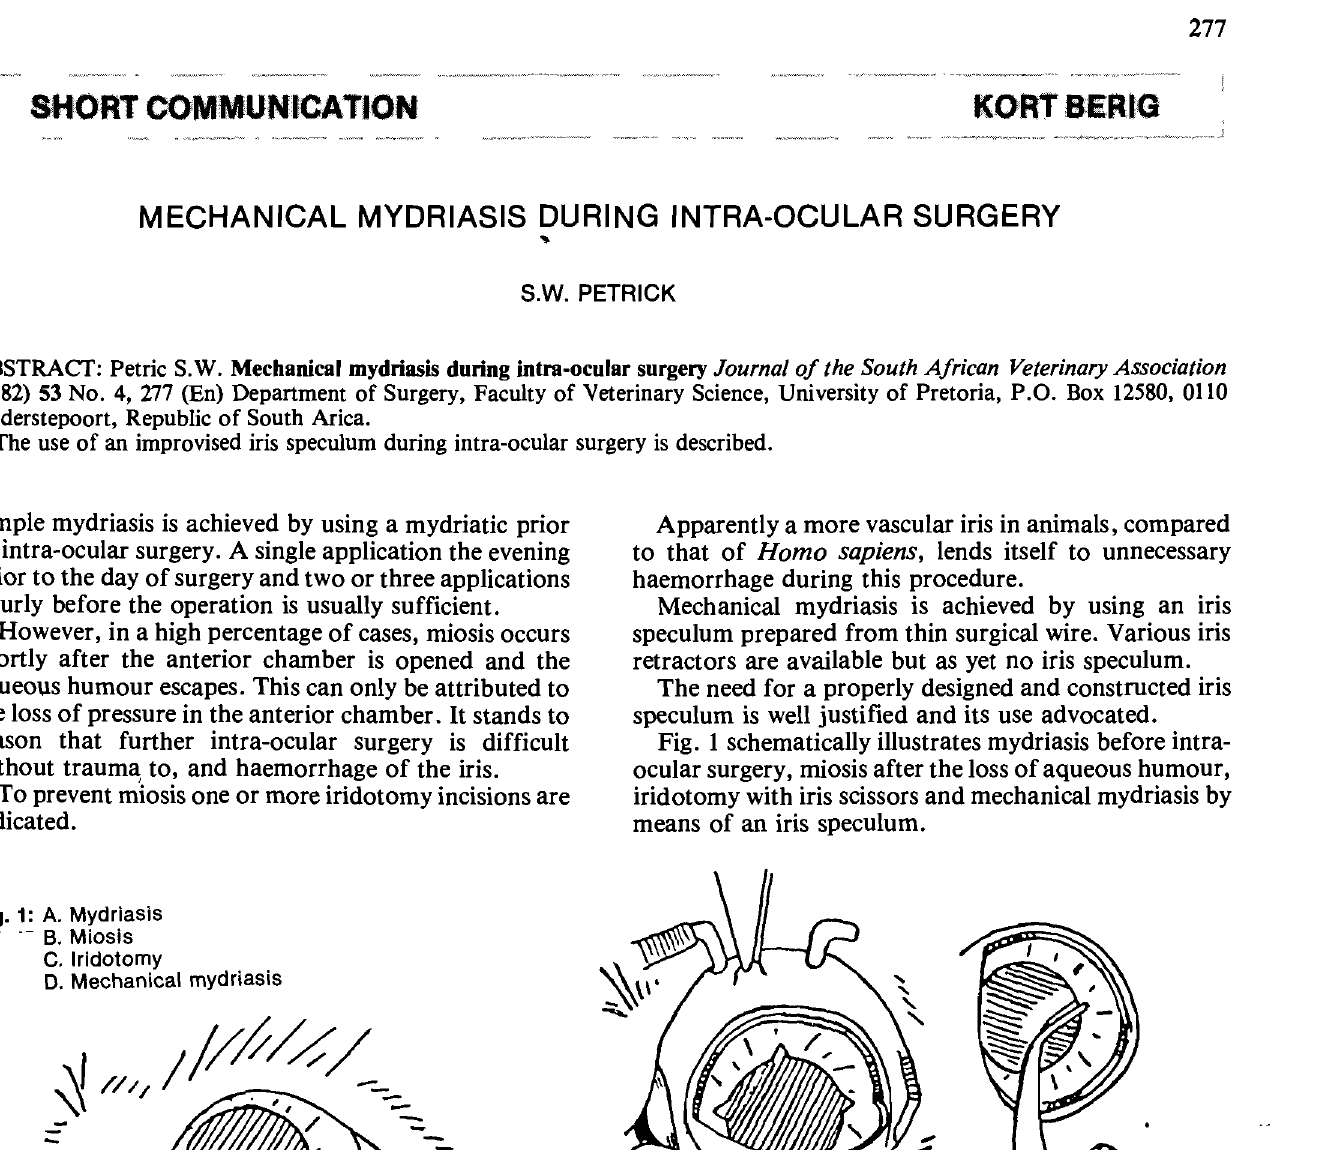
Fig. 1: A. Mydriasis -- B.